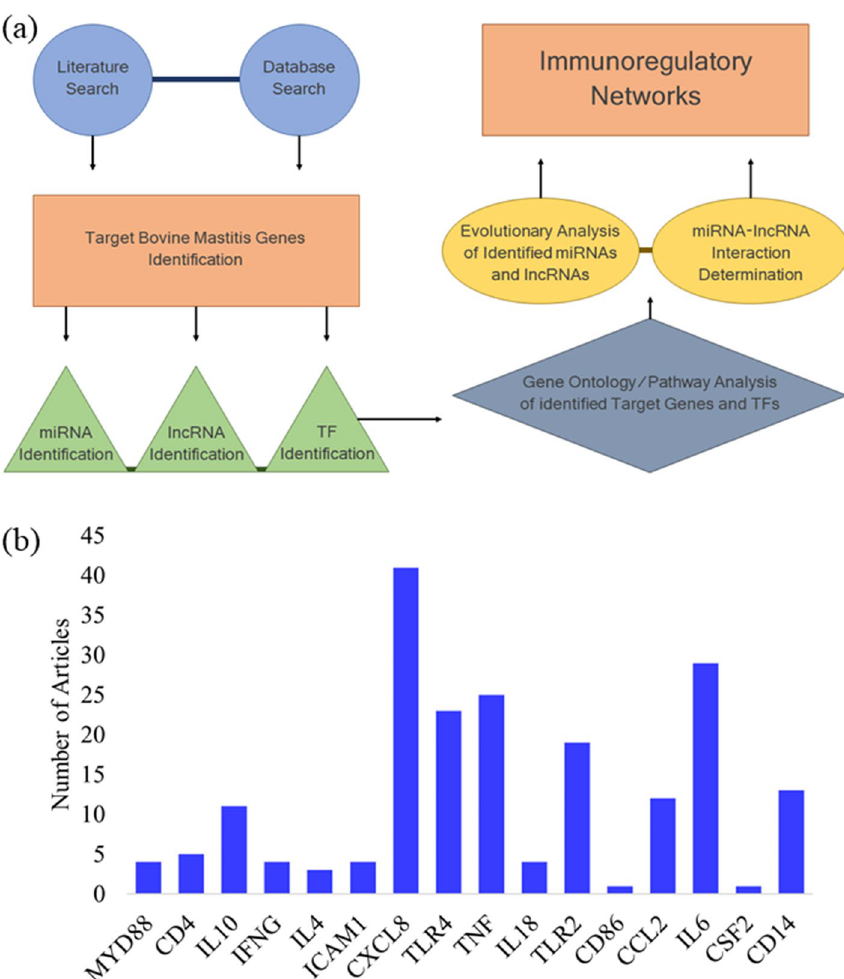
en- us/ micro soft- 365/ power